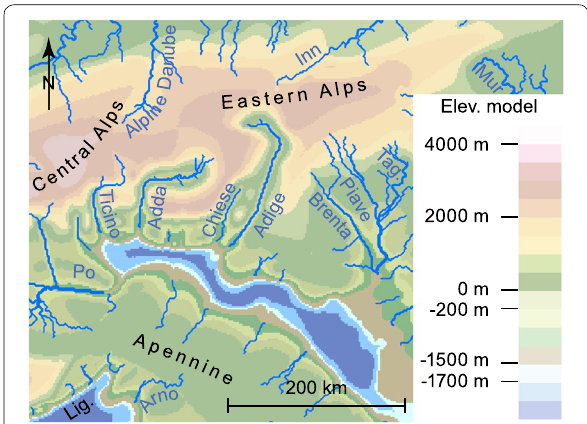
Fig. 5 Paleo-geographic model during the MSC. In this reconstruction, the Southern Alpine rivers have incised valleys. The sea level of the latest MSC was lower than 900 m (Ghielmi et al. − 2013), the rivers are modelled down to 1000 m. The blue colours − represent values below 1500 −